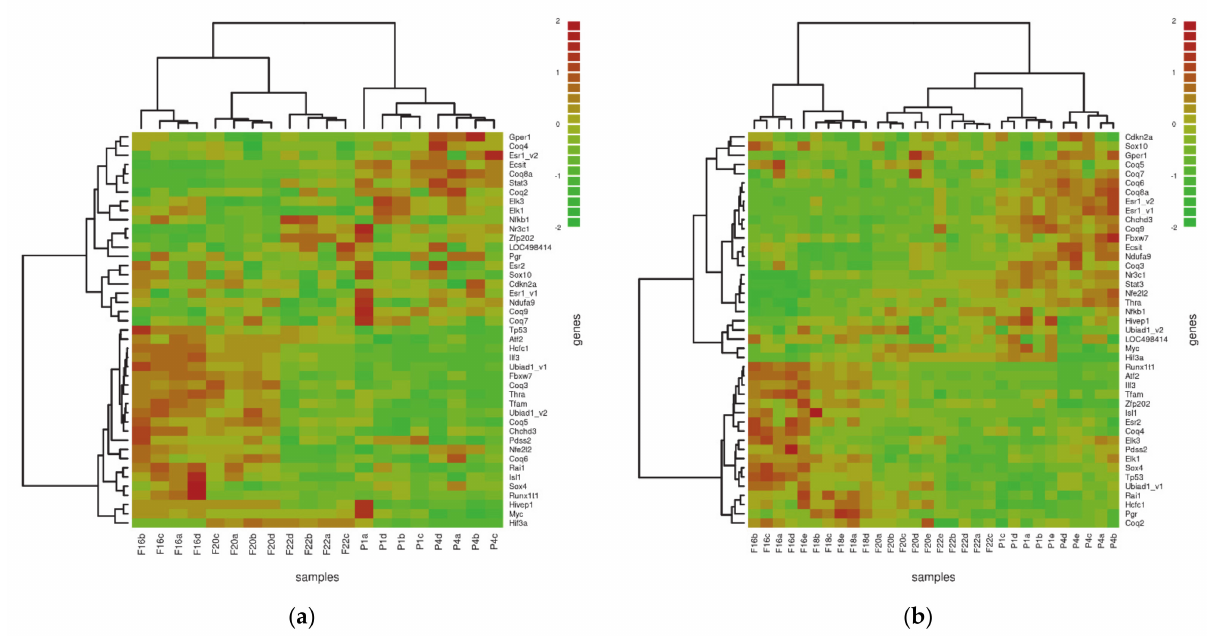
Figure 5. Pearson’s correlation-based hierarchical clustering of genes annotated for CoQ biosynthesis and mitochondrial transcription activity regulators. Data were auto-scaled. ( a ) Heatmap shows that in the liver, Coq2 , Coq4 , Coq7 and Coq9 expression was increased after birth, as was the Coq8a expression. Coq3 and Coq5 expression was decreased. ( b ) This orchestration, contrary to the liver, was not observed in skeletal muscle. Interestingly, in skeletal muscle, Coq3 , Coq5 , Coq6 , Coq7 , Coq9 and Ndufa9 co-clustered with the Coq8a transcript. In both tissues, Tfam expression decreased throughout the observed period, whereas oestrogen-related receptor ( Esr1 ) expression increased. For Esr1 and Ubiad1 , there were two probes on the array (marked with _ v1 or _ v2 ). F—Foetal day, P—Postnatal